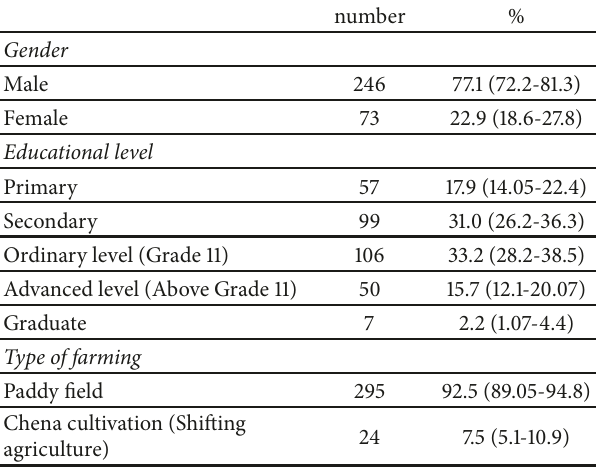
Table 1: Sociodemographic characteristics of the study sample.